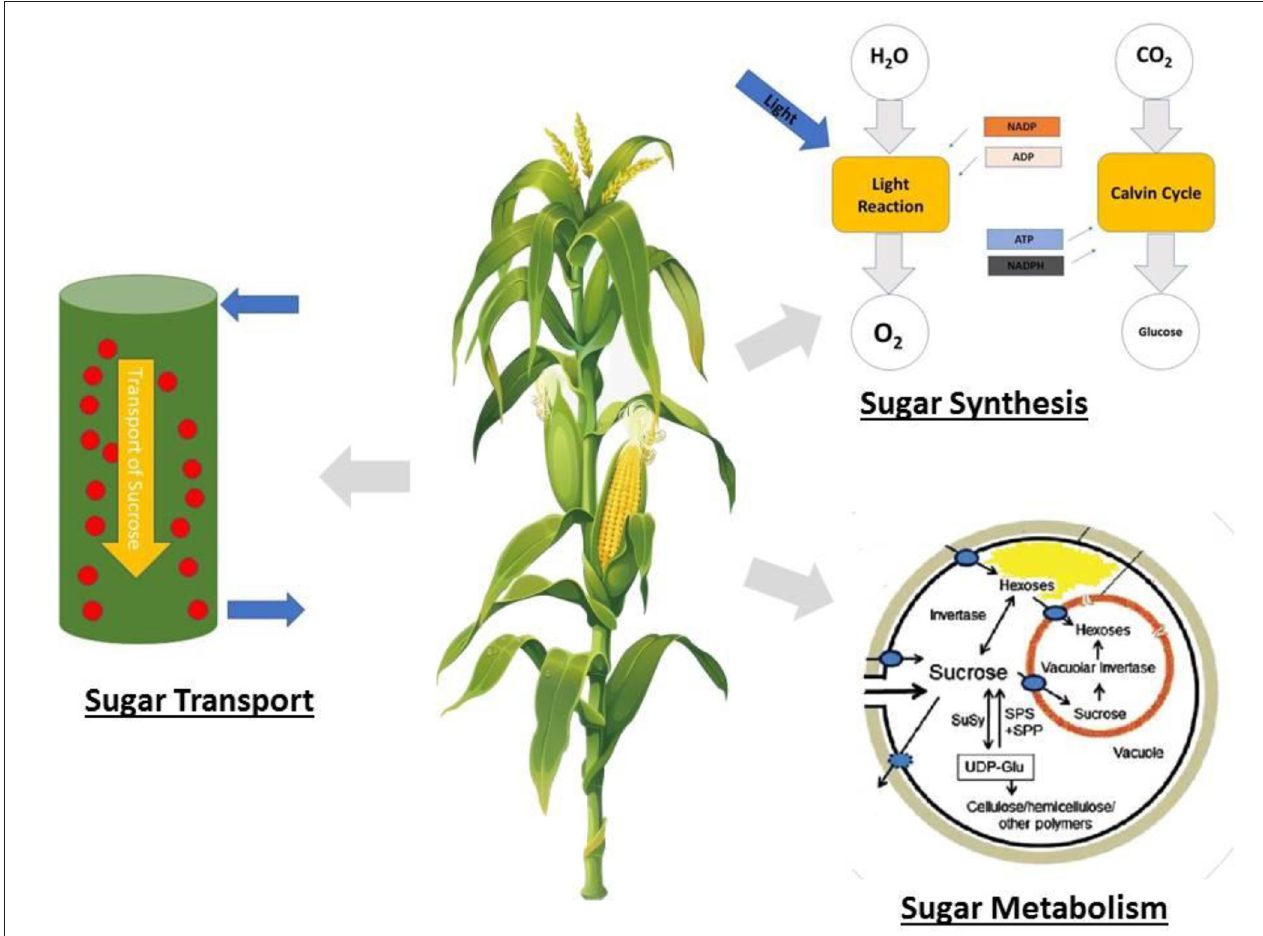
FIGURE 2 | Summary of stem sugar storage and translocation in